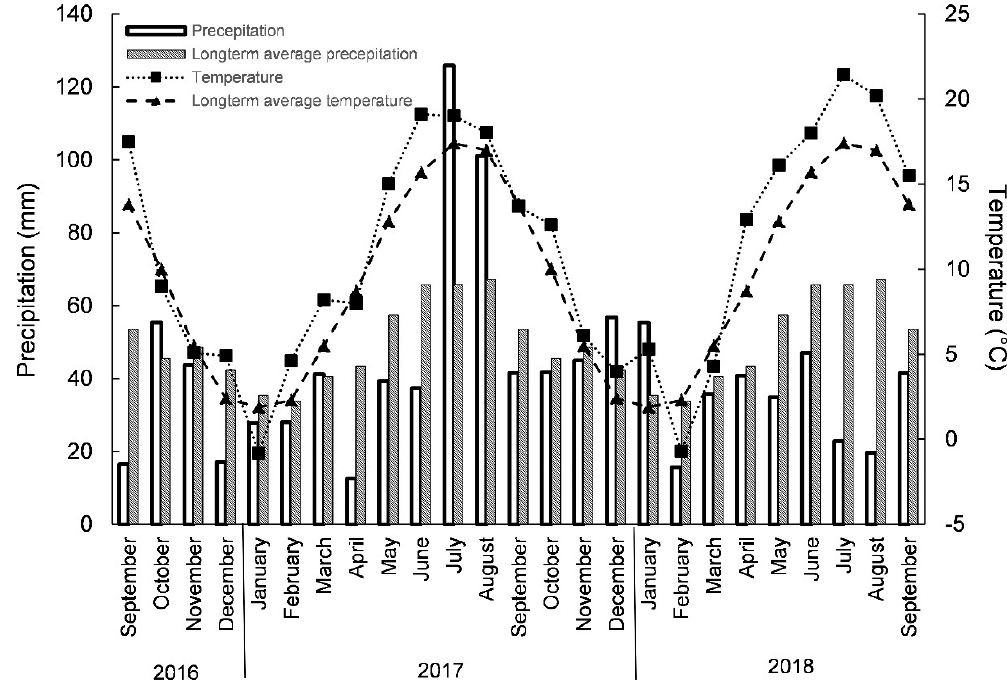
Figure 1. Overview of weather data during the vegetation period (2016–2018). Table 1. Overview of tillage operations for subsoiling with and without organic material. DL: deep loosening with tine, SM: spader machine, DLB: deep loosening with tine and bio compost, SMB: spader machine and bio compost, SMS: spader machine and sawdust, SMCS: spader machine and chopped straw.